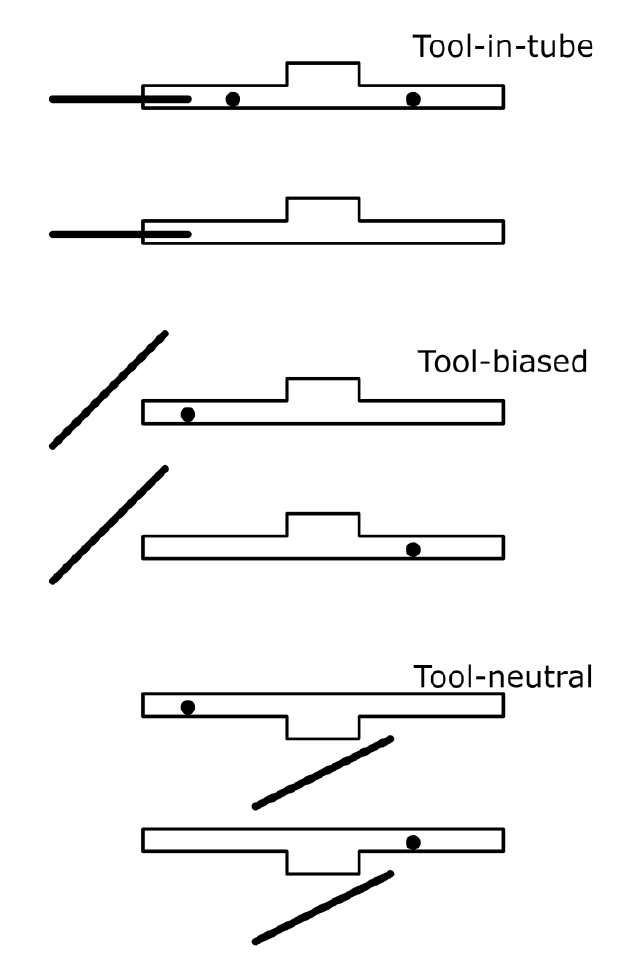
The ‘Trap-Tube’ Task (Povinelli, 2000, Experiment